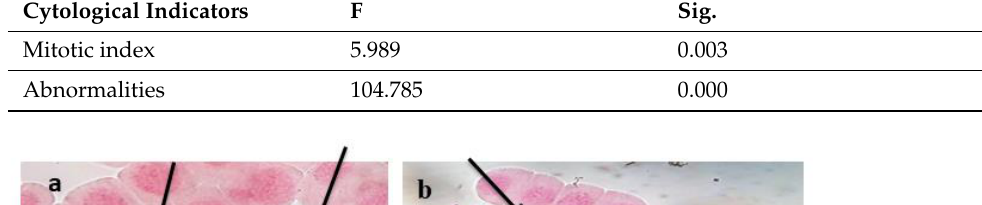
Table 8. One-way analysis of variance of cytological indicators of examined root tips of Vicia faba affected by biochar after microplastic addition to soil.